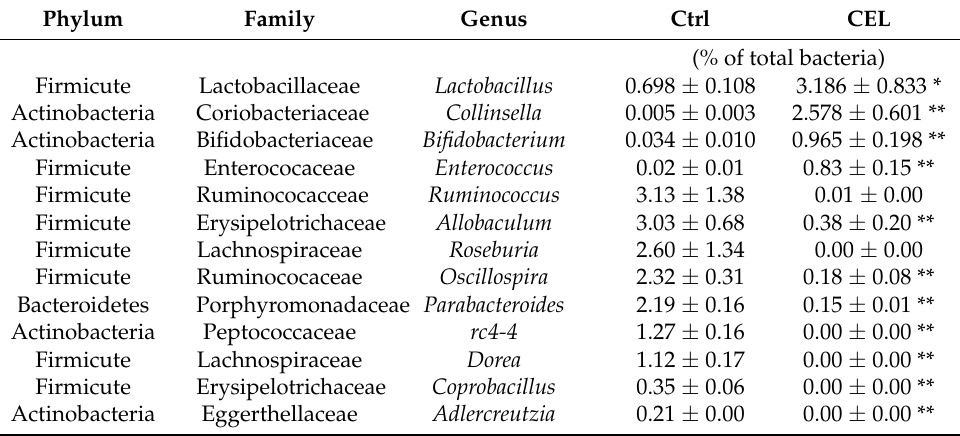
Table 1. Effects of supplemental CEL on the relative abundance of genera in cecum of